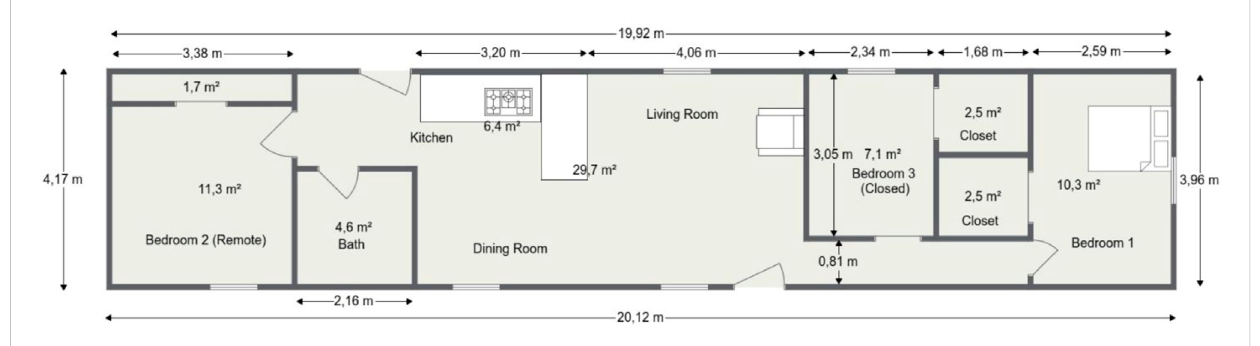
FIGURE 2 Sectional view of the experimental facility (Bukowski, 2007).